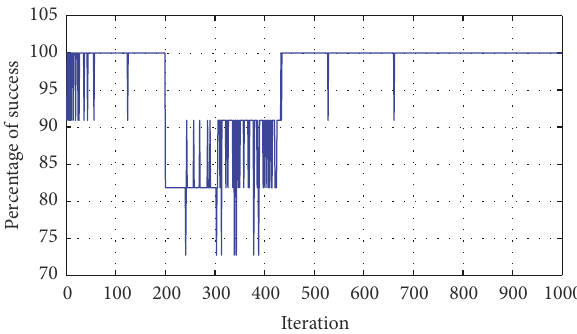
Figure 9: Agent-based prediction performance of the parking